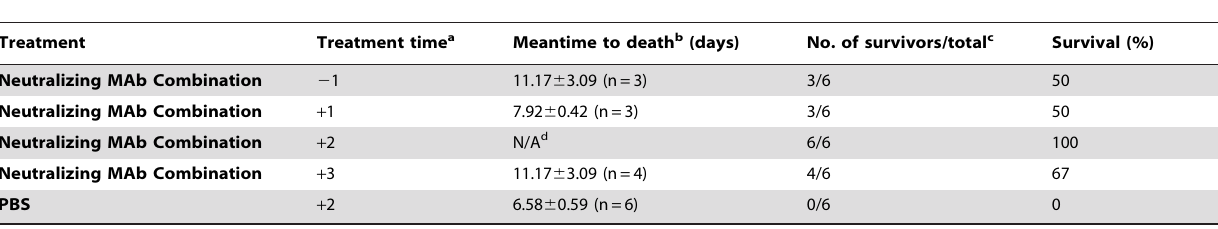
Table 5. Protective Efficacy of MAbs in Guinea Pigs Infected with GA-EBOV.